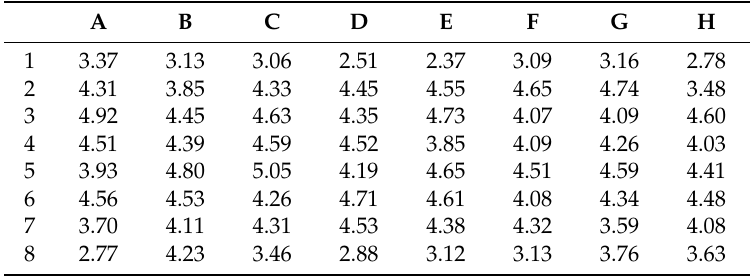
Table A4. Measured values of air velocity distribution in Experiment A2 (m/s).